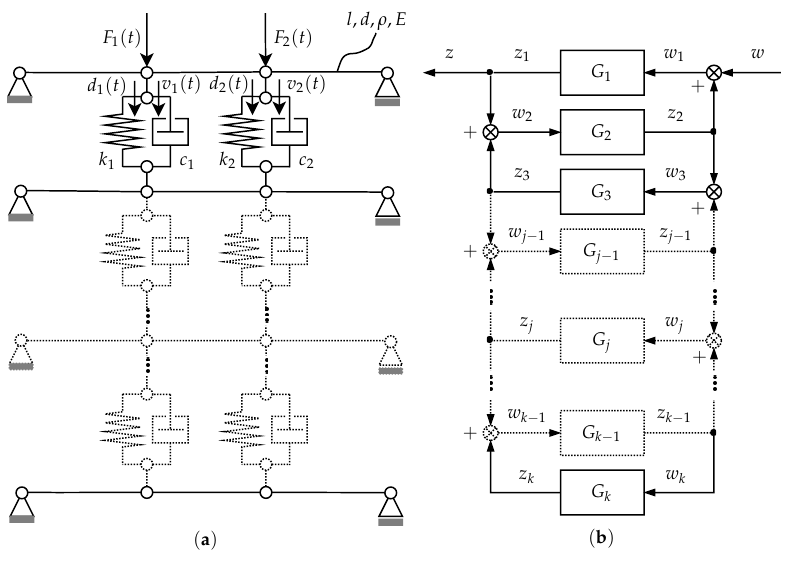
Figure 8. A series of simply supported Euler beams mutually interconnected by springs and dampers: ( a ) Mechanical schematic of an interconnected system. ( b ) Block diagram representation of the system, where the systems with odd indices, i.e., G 1 , G 3 , G j , . . . , G k are dynamical systems representing LTI models of discretized beams, while the systems with even indices, i.e., G 2 , G 4 , G j systems of static gain representing springs and dampers between each beam. Table 1. Material properties of the beams, springs and